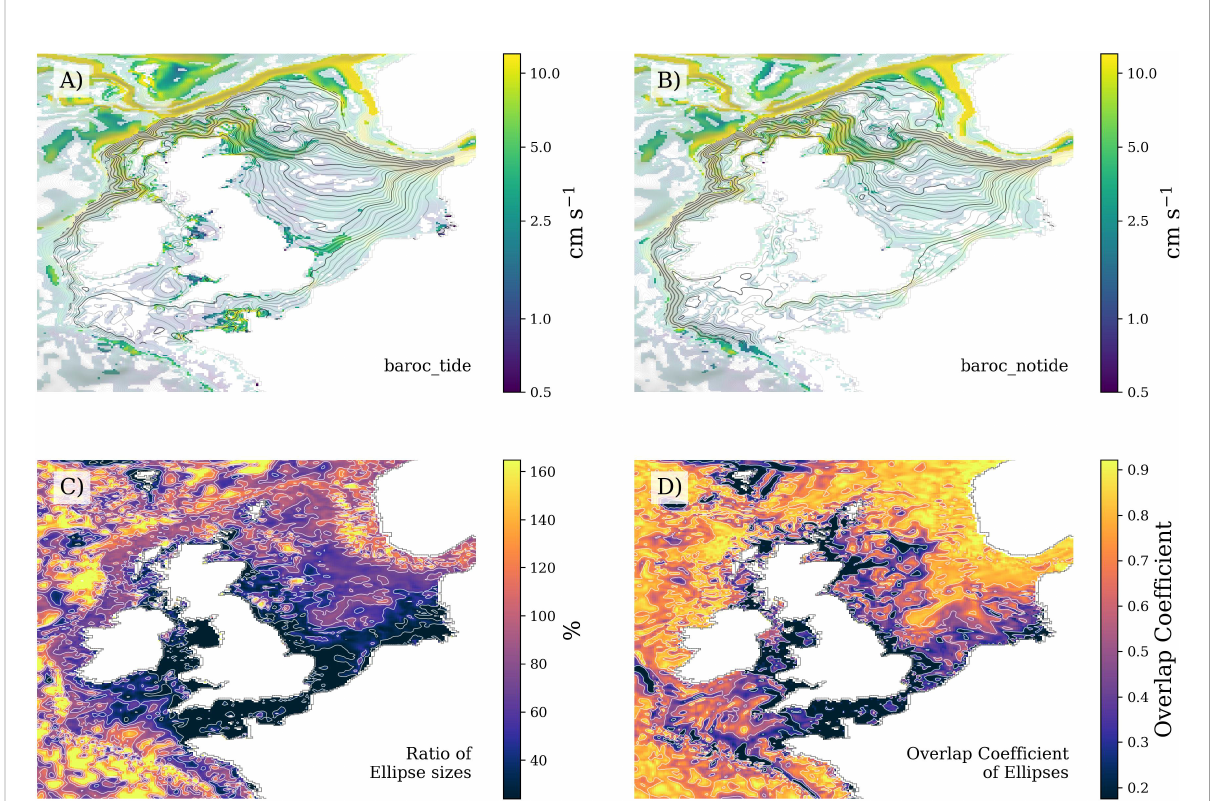
FIGURE 2 Variability of the residual circulation climatology. (A, B) The signi fi cance of the residual current at the 5% level (shown in bold). When the 1 standard deviation ellipse does not include zero, the (quasi-steady) current is shown shaded. See text and appendix for further details. (C) The ratio of the mean current variability (the area of the baroc_tide 2.45 standard deviation ellipse divided by that of baroc_notide). Over most of the shelf, there is much greater variability in baroc_notide. (D) The similarity of the residual current distributions of the two simulations as quanti fi ed by the Overlap Coef fi cient (OVL, see Residual current signi fi cance and the Appendix for details): the integrated volume under the two Gaussian distribution surfaces. Where the distributions are very different, OVL ≈ 0, where the distributions are identical OVL=1. Contours in (C, D) increment every 25%